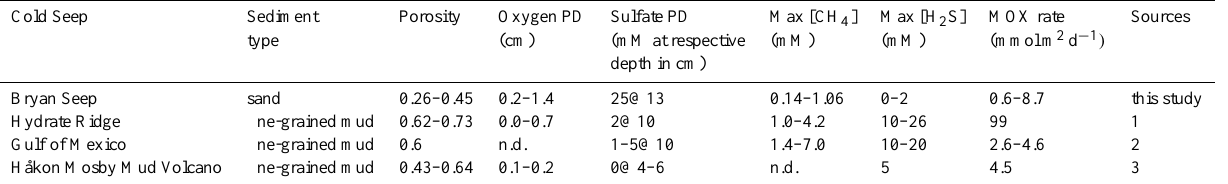
Table 2. Comparison of biogeochemical parameters between Bryan Seep (shallow sandy sediment) and deep-sea seeps (fine-grained muddy sediments). Considered are sites revealing the highest AOM rates and not containing major bioturbation/bioirrigation activity of clams or annelid worms. PD=penetration depth; mM@cm=concentration measured at max sampling depth or where sulfate reached zero; Max [CH4] = maximum methane concentration measured in the top 15cm of the sediment at atmospheric pressure; Max [H 2 S] = maximum sulfide concentration measured in the top 15cm of the sediment; MOX = methane oxidation (aerobic and anaerobic) integrated over 10cm